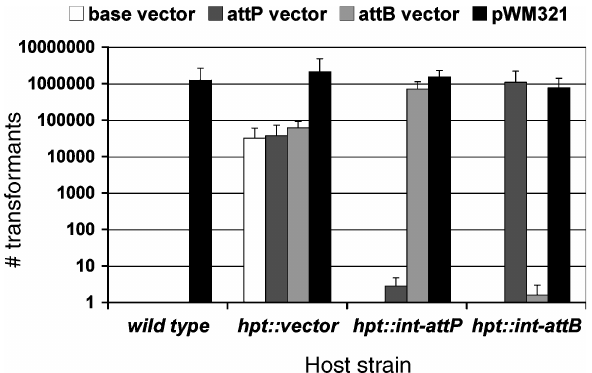
Figure 3. Transformation efficiencies in Methanosarcina using the φ C31 integrase-mediatedintegration. Various Methanosarcina strains were transformedto Pur R with 2 µg of the indicated plasmid DNA and the number of colonies obtained was quantified. The presence of φ C31 Int recombination sites (attB or attP) are indicated. Results shown are means of least three trials. Host strains used were